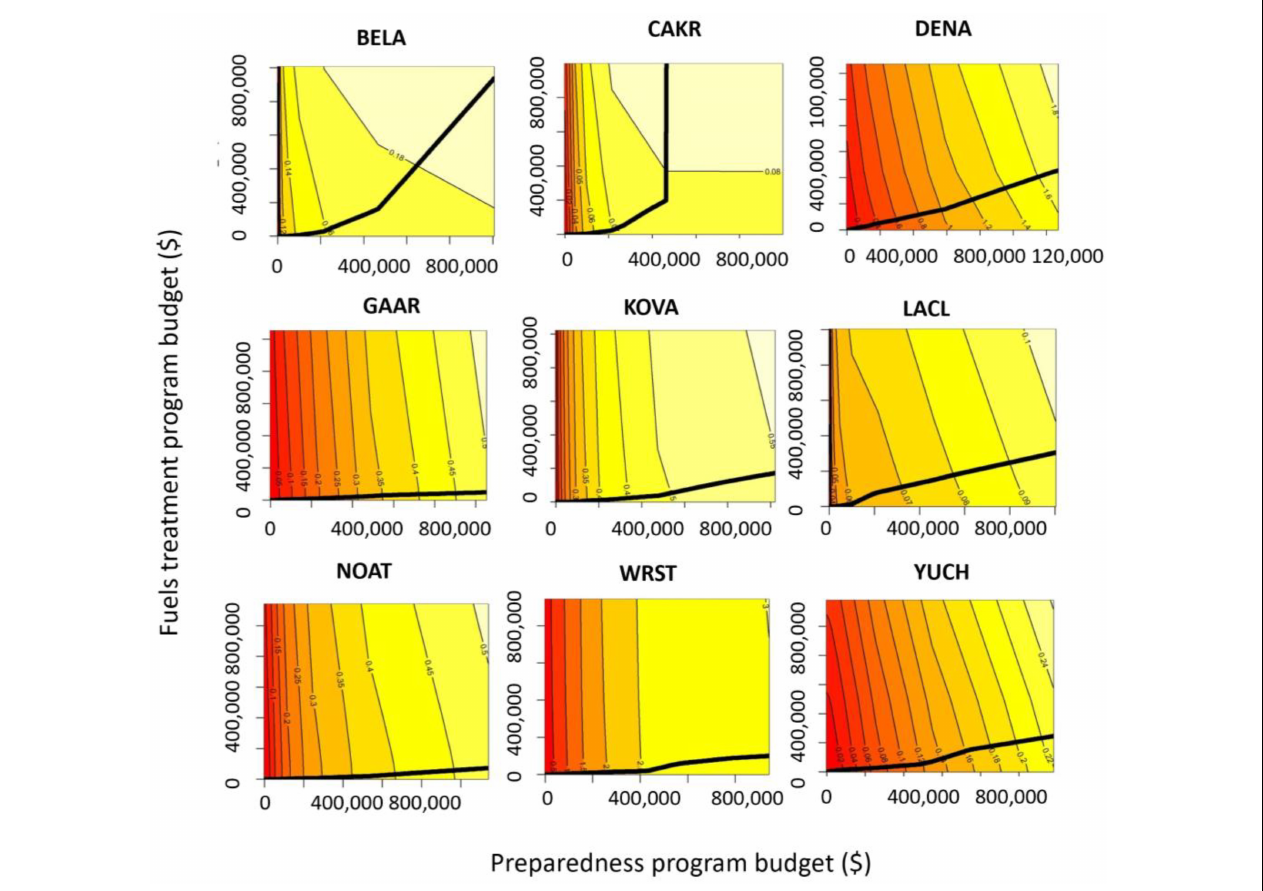
FIGURE 5 | Gradients for the nine national parks in the Alaska Fire Management Zone. ROI increases as the surface changes from red to yellow.